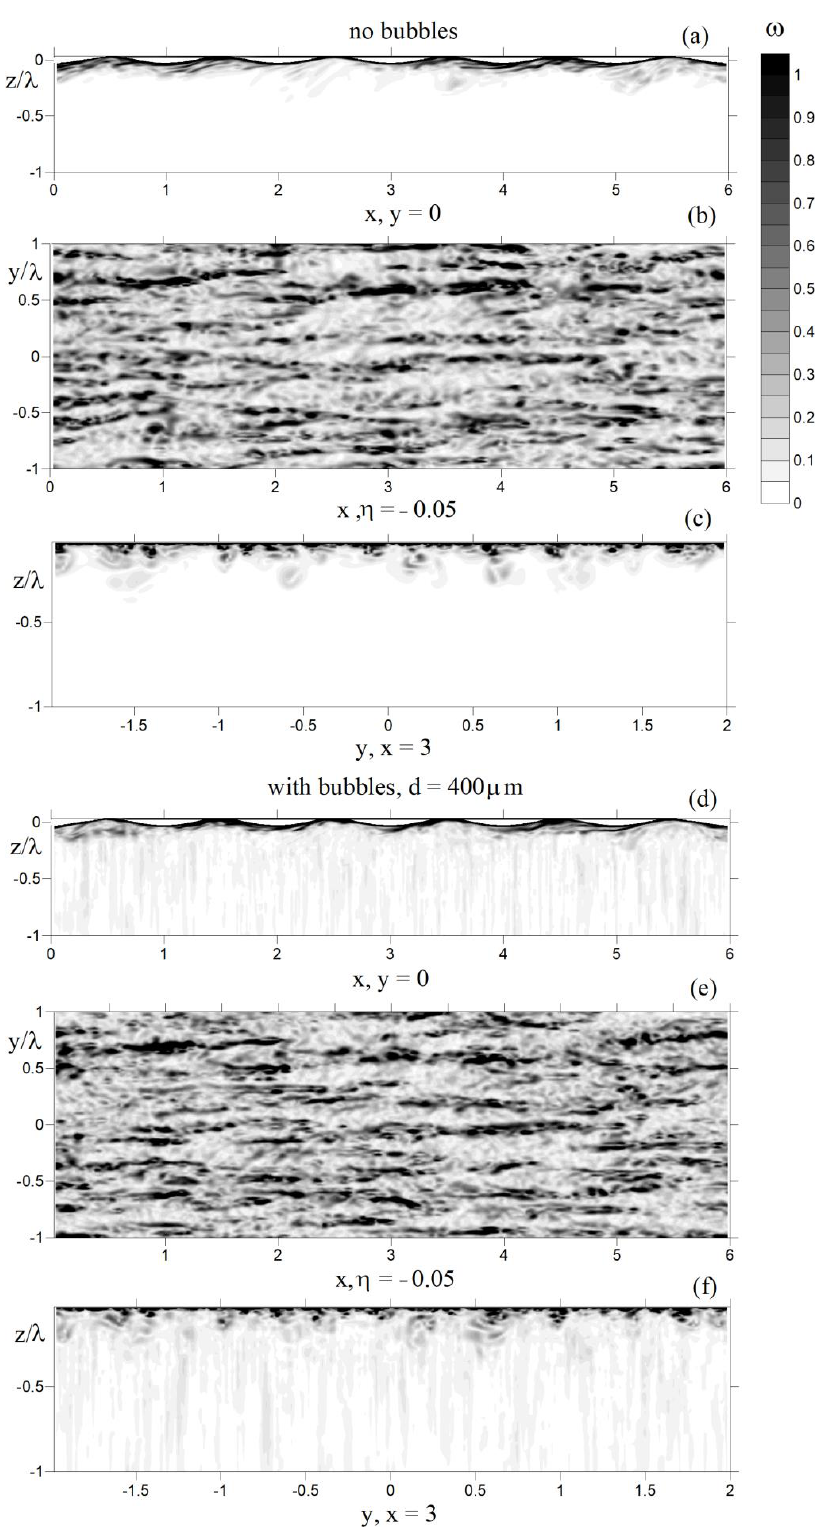
Figure 2. Instantaneous distribution of the vorticity modus, ω , obtained using DNS in central ( x , z ) ( a , d ) and ( y , z ) ( c , f ) planes and in a near-surface ( x , y ) plane at η = −0.05 ( b , e ). Panels ( a – c ) are for the no-bubbles case, and panels ( d – f ) are for DNS with bubbles with diameter d = 400 µm. In both cases, surface drift velocity, Equation (21), is added at the waved boundary accounting for the wind stress. Wave slope ka = 0.2.